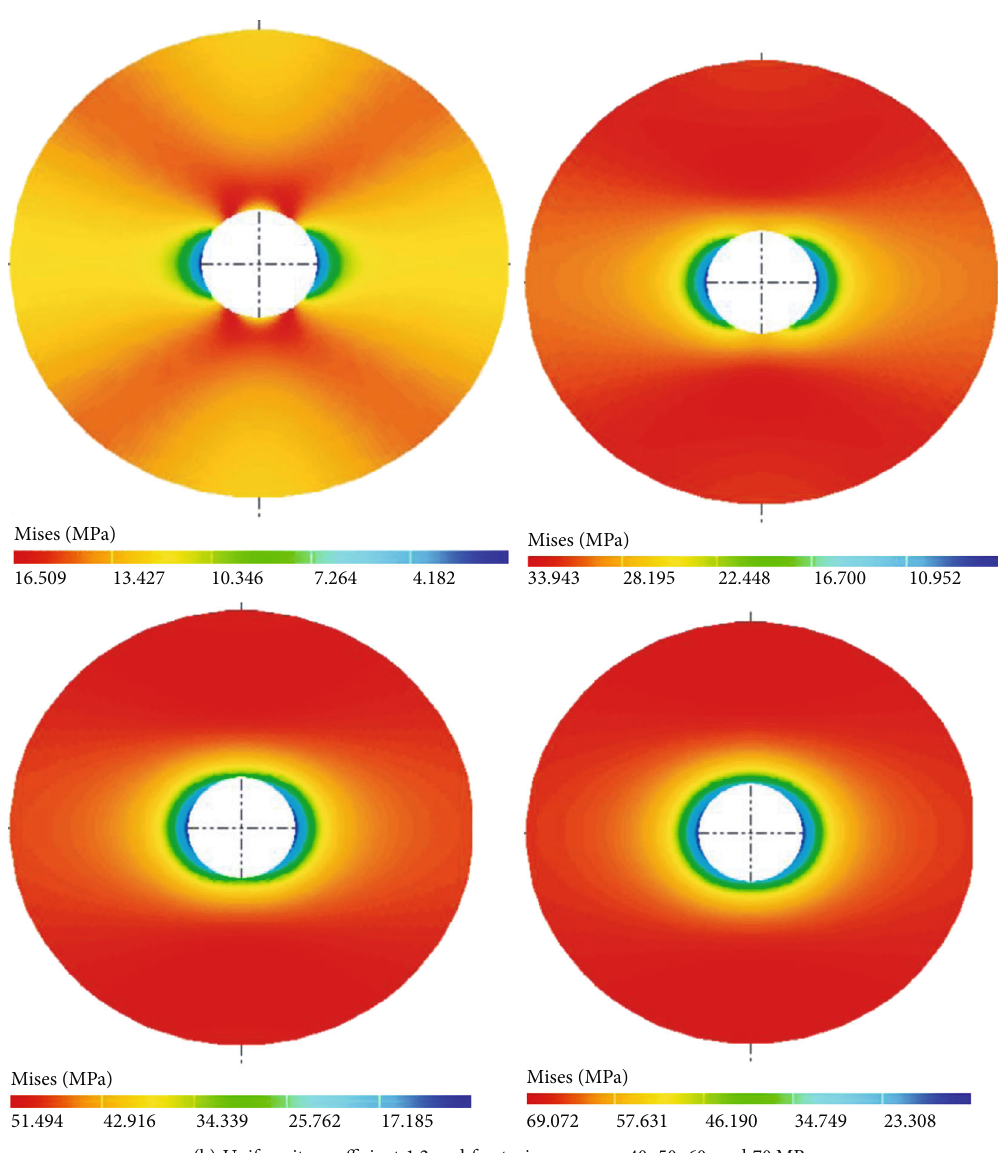
Figure 10: Mises stress near the wellbore under the uniformity coe ffi cient-fracturing